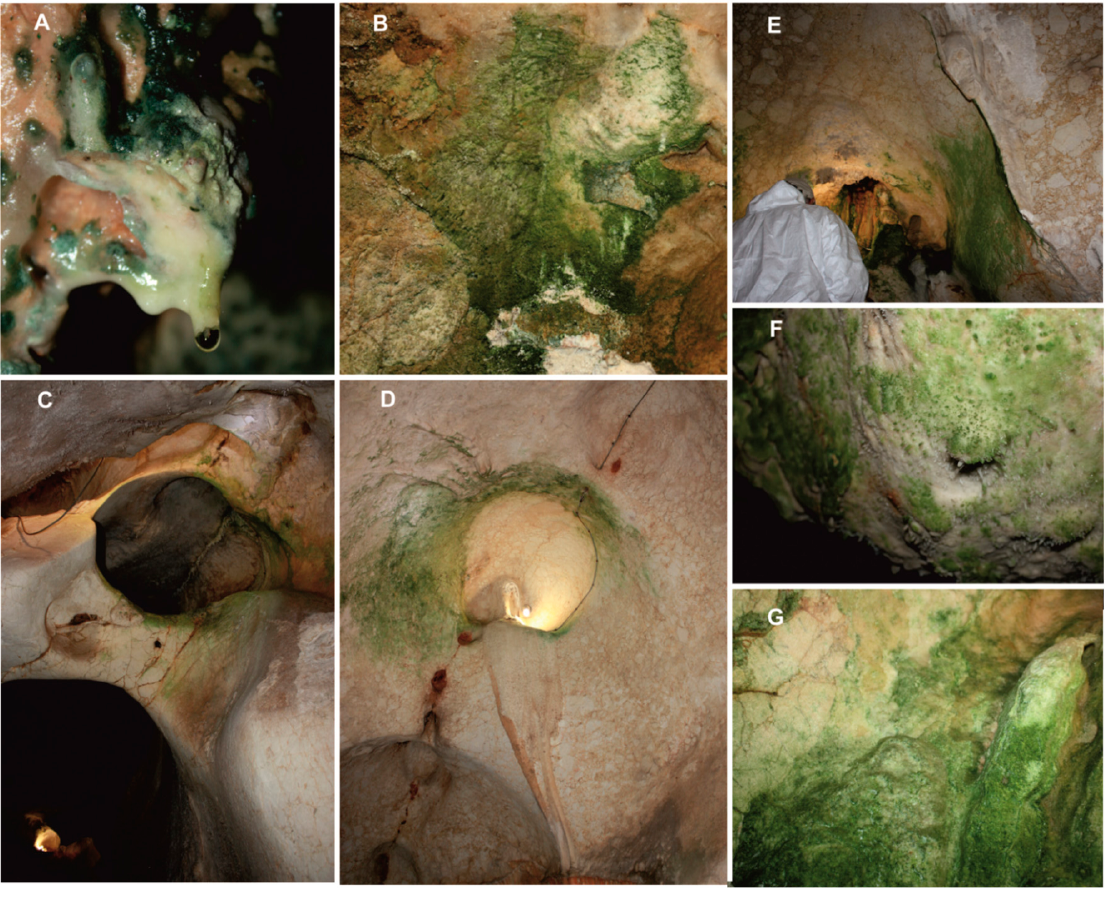
Figure 3. Speleothems and cave walls abundantly coated by phototrophic biofilms in Cueva del Tesoro. ( A ) Sala del Aguila; ( B ) Sala de Lagos; ( C ) Sala de Marco Craso; ( D – G ) Sala de Lagos.